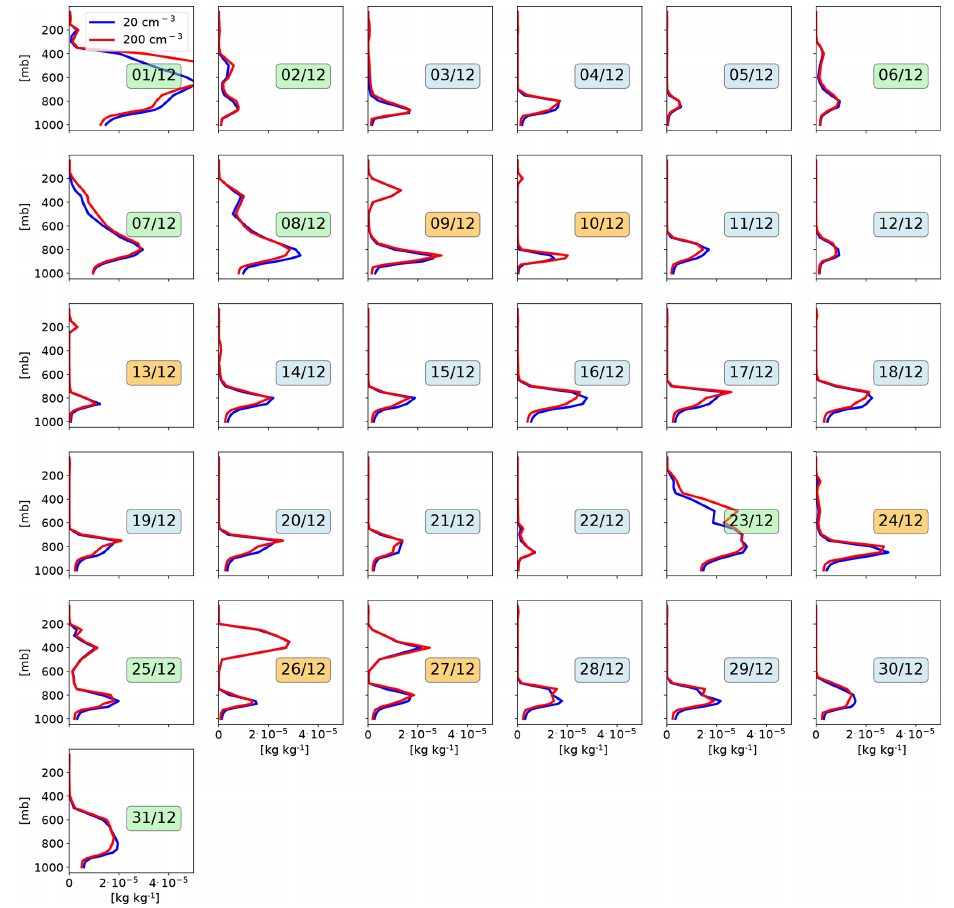
Figure 4. Same as Fig. 3 but for the NARVAL 1 month (December 2013).